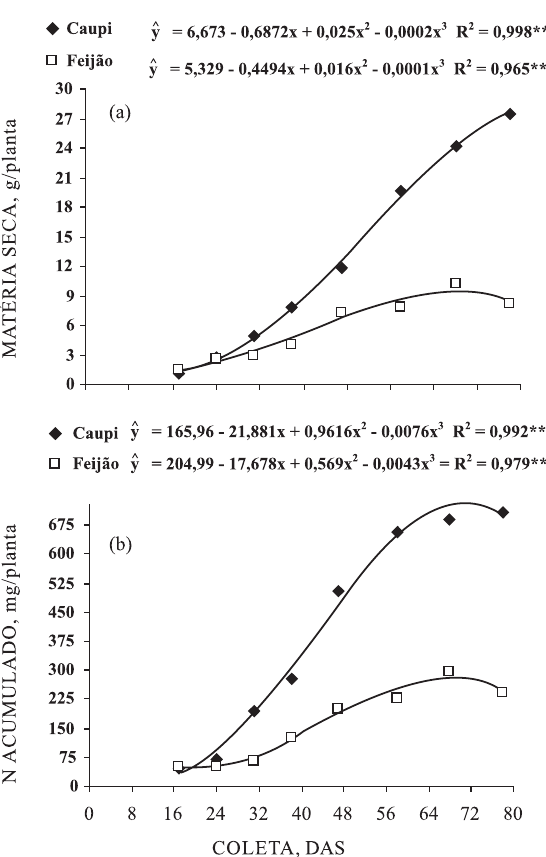
Figura 1. Produção de massa de matéria seca da parte aérea (caule + ramos + folhas + pedúnculos e vagens) (a) e quantidade de N acumulado (b) em feijão-comum e feijão-caupi, em função de diferentes épocas de coleta. **: significativo a 1 %.